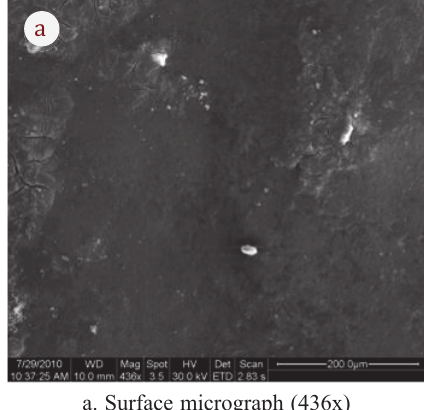
Fig. 7 Micrographs of the membrane from cleaning 1 in sequential cleaning